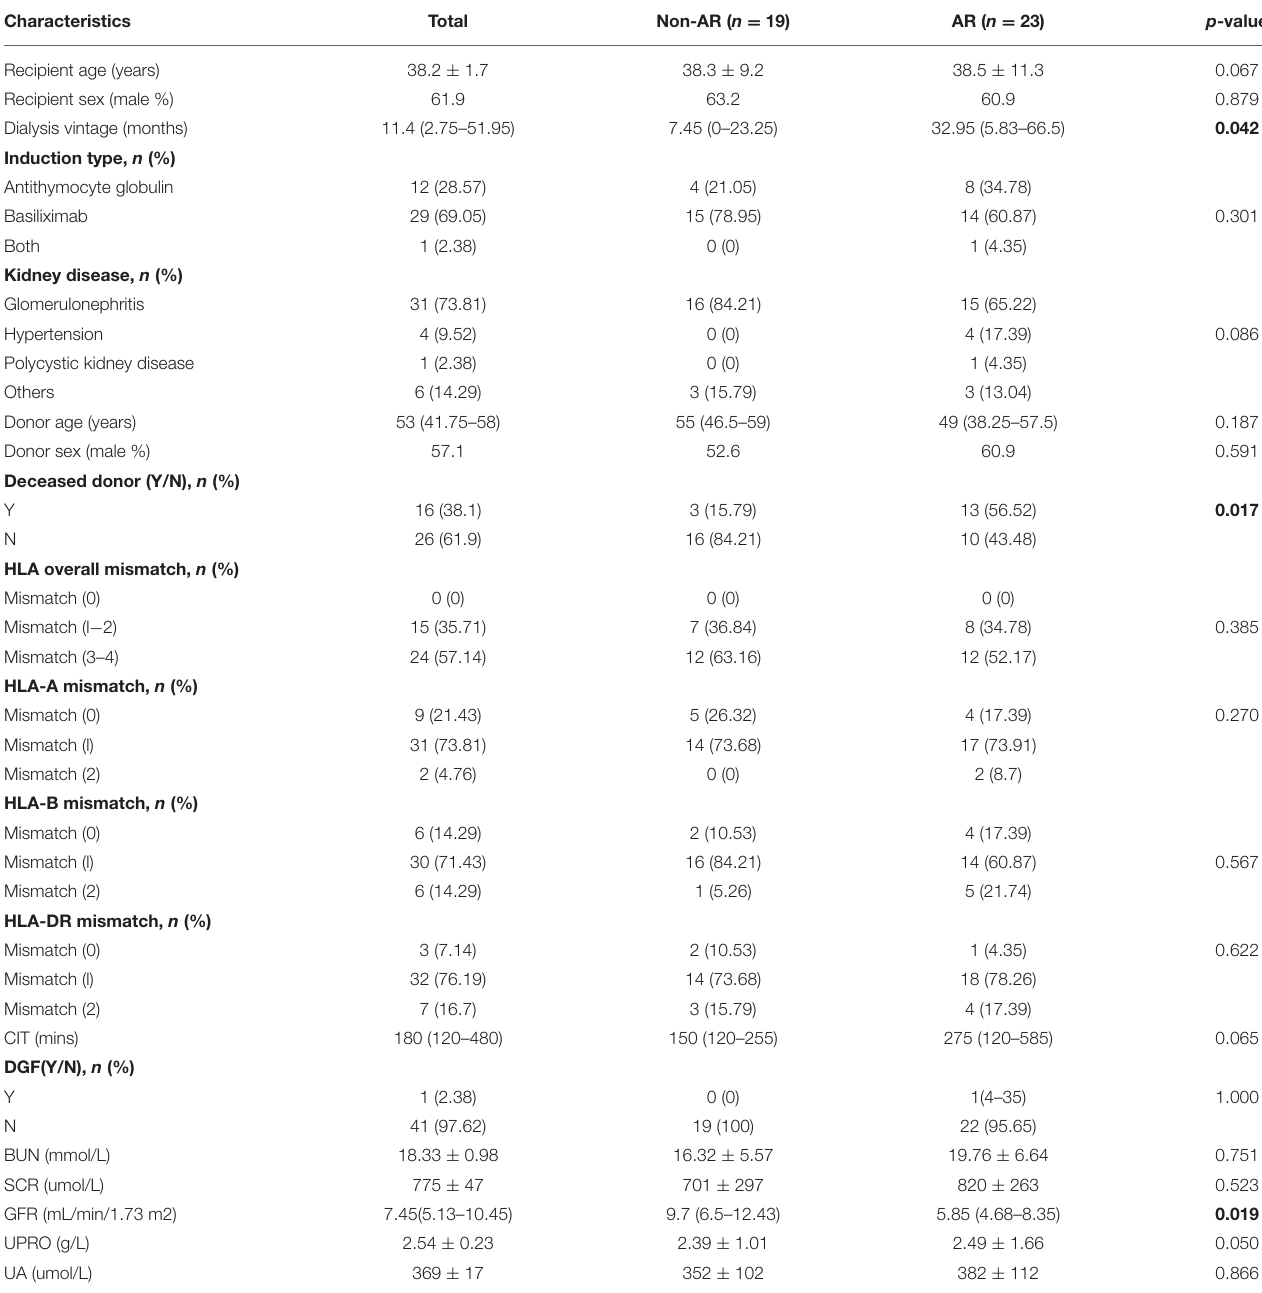
TABLE 1 | Demographic and clinical characteristics of kidney allograft recipients.